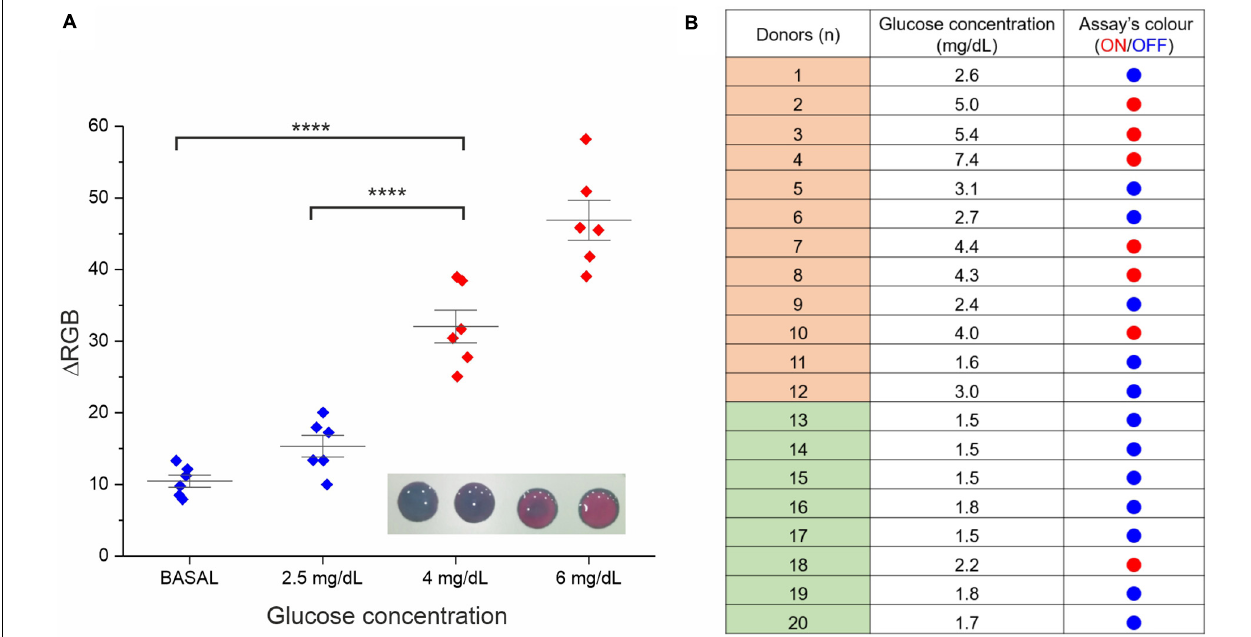
Frontiers in Bioengineering and Biotechnology |